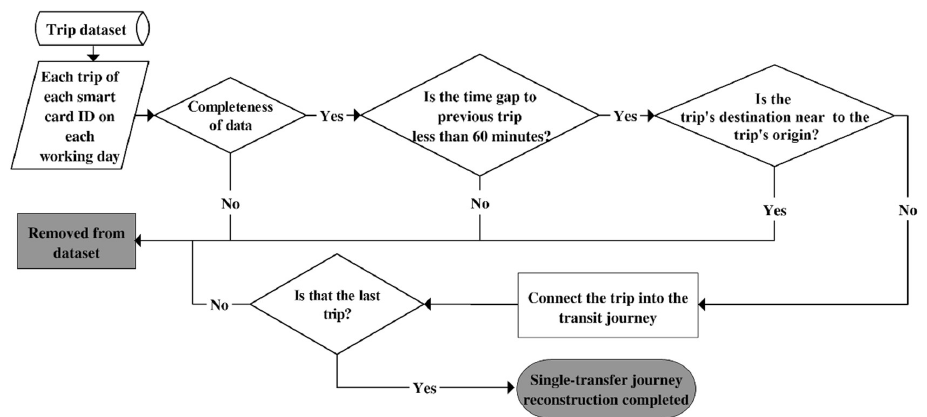
Figure 1. Process to construct single-transfer travel journeys.